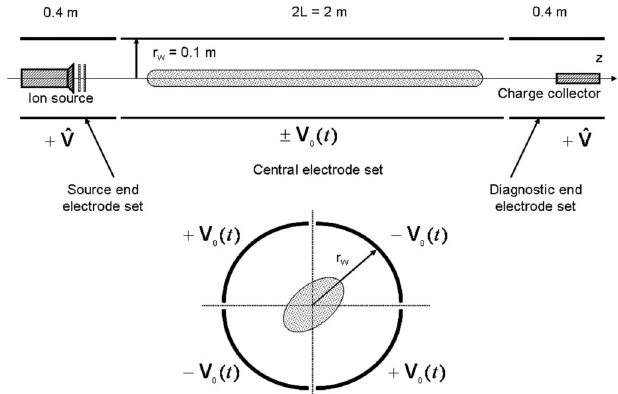
FIG. 1. Schematic of the PTSX device showing the quadrupole electrodes, ion source, and charge